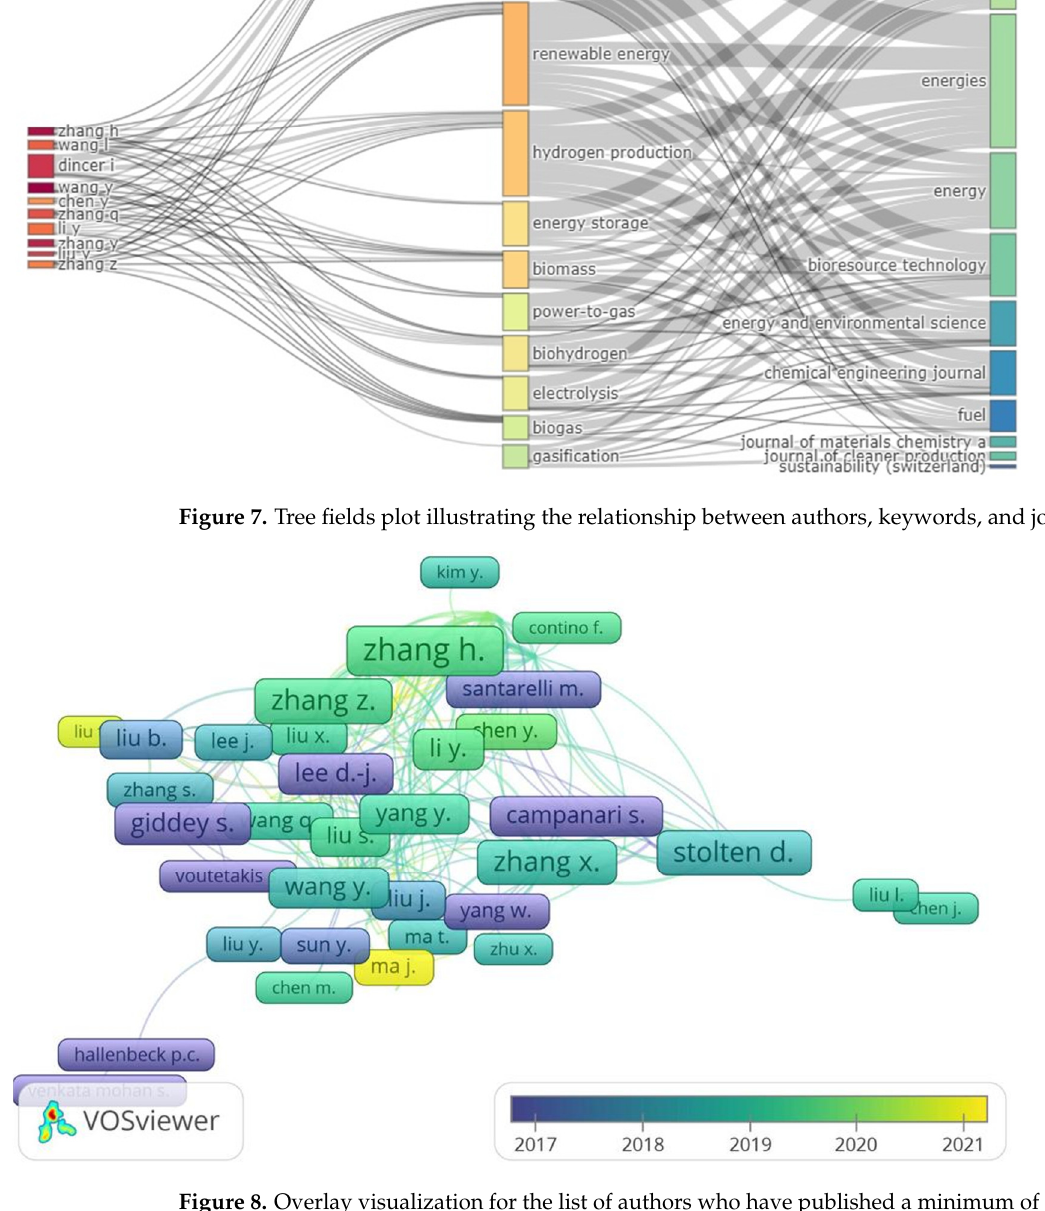
Figure 8. Overlay visualization for the list of authors who have published a minimum of five